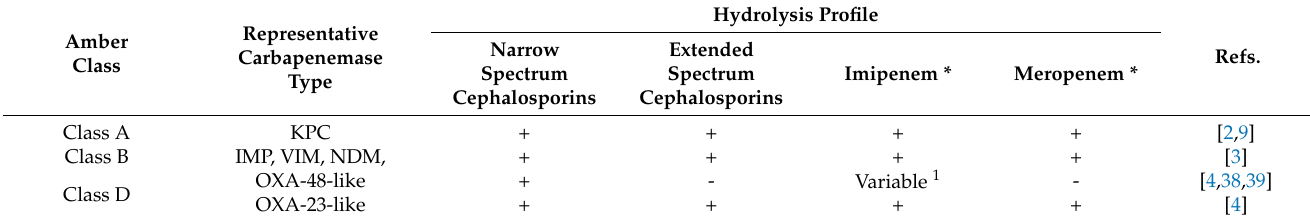
Table 2. Common β -lactam hydrolysis profile of